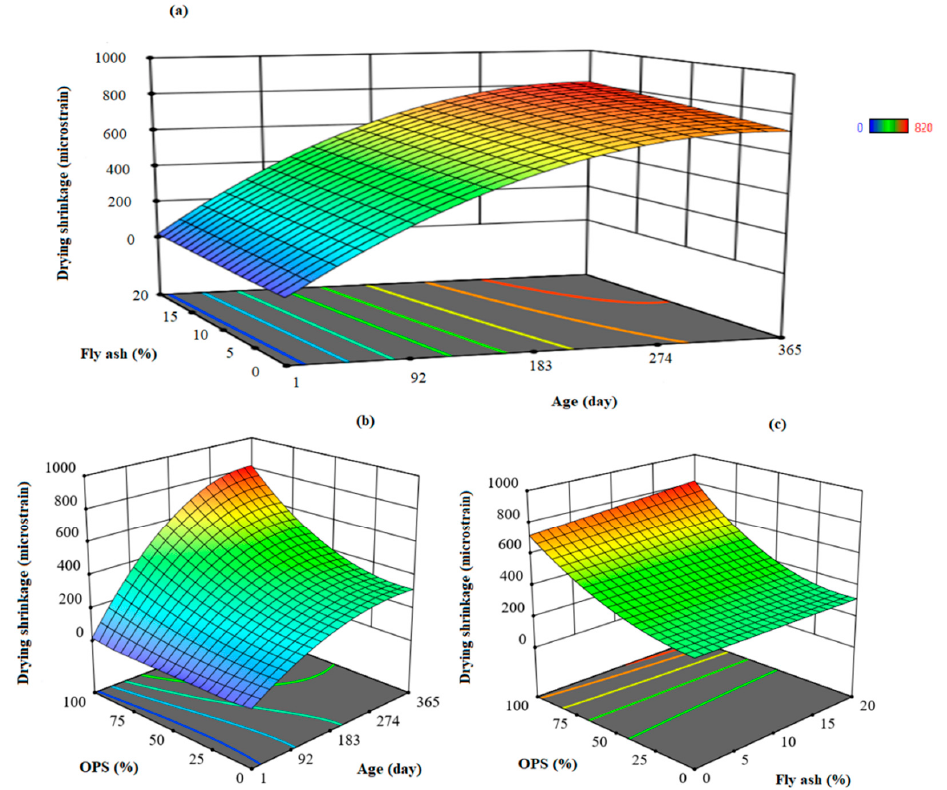
Figure 12. 3D response surface plot for drying shrinkage of LWC at ( a ): 100% OPS, ( b ): 20% FA, and ( c ): age of 365 days under air curing.